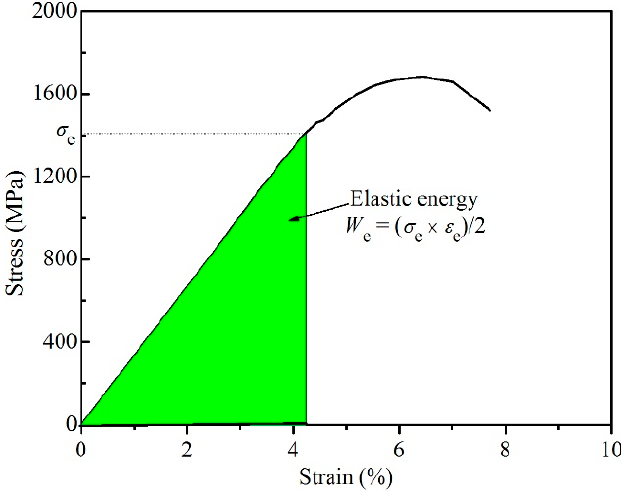
Figure 7. The elastic energy ( W e ) of the Ti 75 Fe 15 Sn 5 Mo 5 alloy.